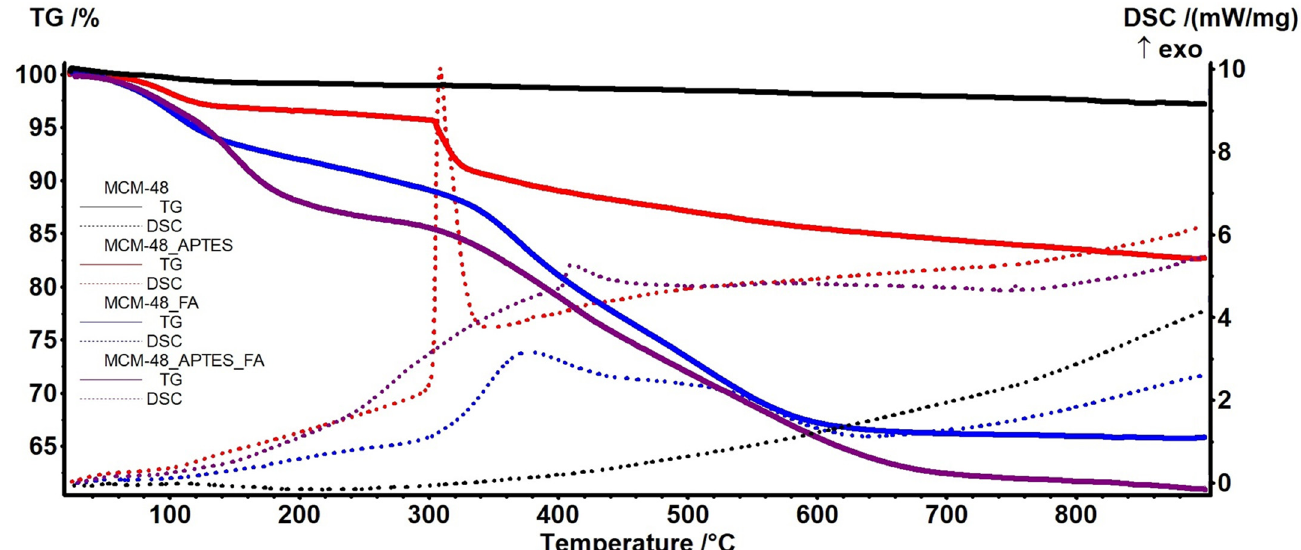
Figure 9. The TG (solid)—DSC (dotted) curves for the MCM-48 (black); MCM-48_APTES (red); MCM-48_FA (blue) and MCM-48_APTES_FA (purple). Table 3. Surface density of adsorbed H2O molecules and -OH